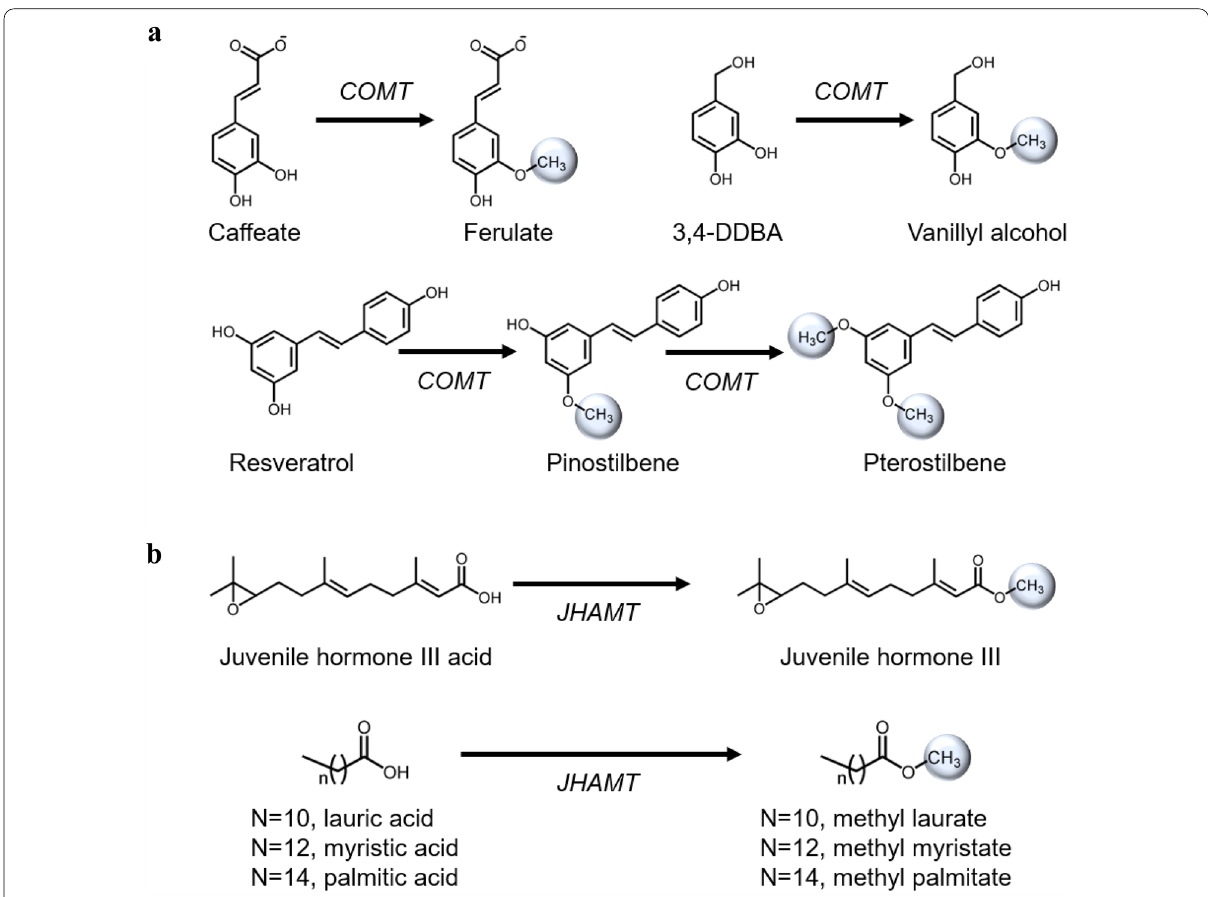
Fig. 4 Reactions of promiscuous methyltransferases for small molecule production. a Caffeate O-methyltransferases (COMT) readily accept structurally similar compounds, such as caffeate, 3,4-dihydroxybenzyl alcohol (3,4-DDBA) and resveratrol. b Juvenile hormone acid O-methyltransferase (JHAMT) can methylate C12–C16 fatty acid. Refer to Table 1 for more information on the